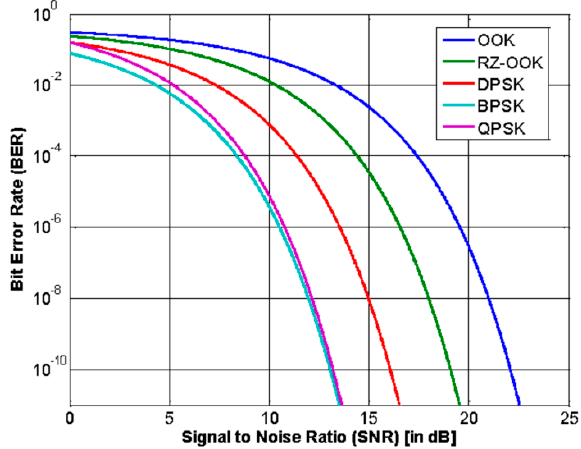
Figure 5. The bit error rate performance for free space communication systems under various modulation method as a function of single to noise ration.